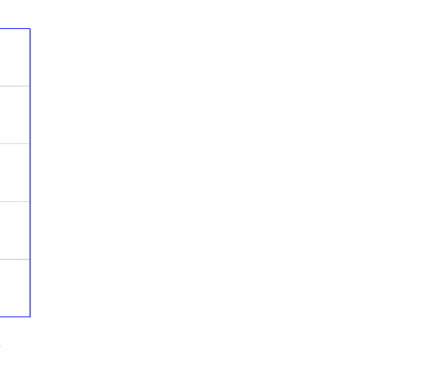
Figure 7. Porosity reduction versus the applied overbalance